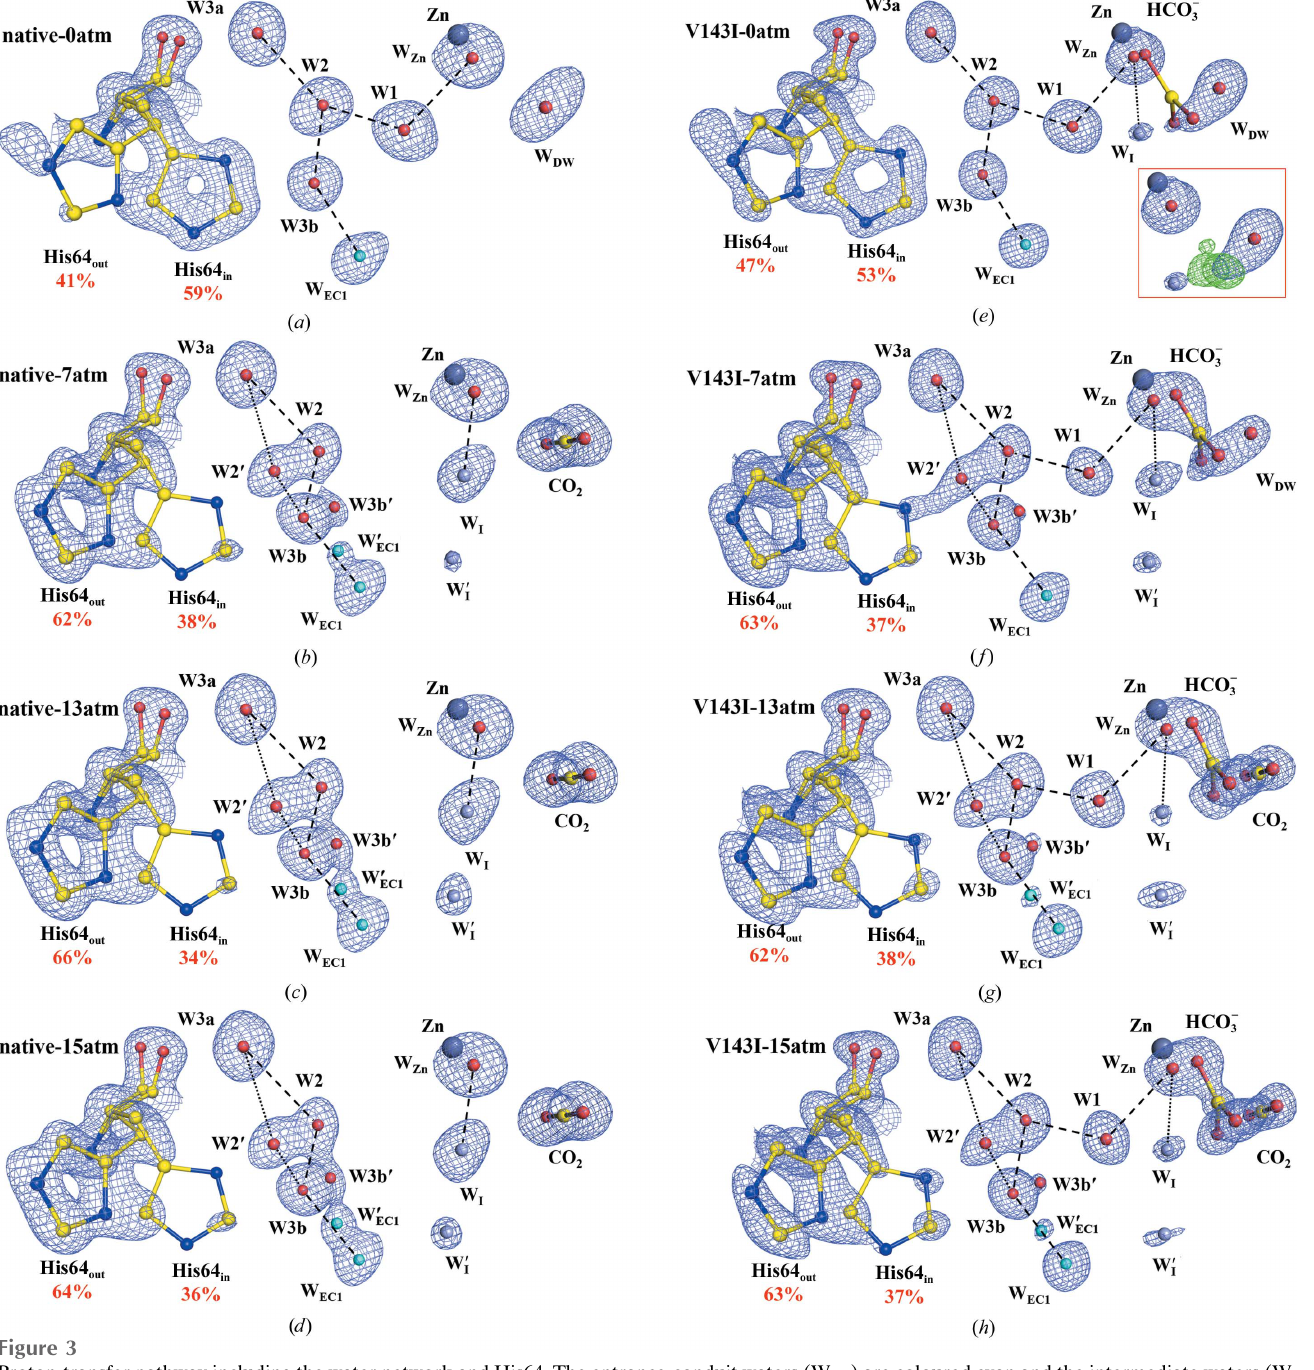
Figure 3 Proton-transfer pathway including the water network and His64. The entrance-conduit waters (W EC ) are coloured cyan and the intermediate waters (W I and W I 0 ) are coloured steel blue for clarity. The electron density (2 F o (cid:2) F c ) is contoured at 1.5 (cid:2) where not indicated otherwise. The major hydrogen bonds between water molecules are represented by dashed lines, while alternative hydrogen bonds that are mutually exclusive are represented by dotted lines. ( a )–( d ) Native CA II structures. ( e )–( h ) V143I CA II structures. W I 0 at 7, 13 and 15 atm and W 0 EC1 at 15 and 13 atm are contoured at 1.25 (cid:2) , and W I at 0 atm is contoured at 1.0 (cid:2) . The inset (red box) in V143I-0atm shows the difference map ( F o (cid:2) F c contoured at 3.0 (cid:2) ; green) when the HCO 3 (cid:2) molecule is not included in the structure